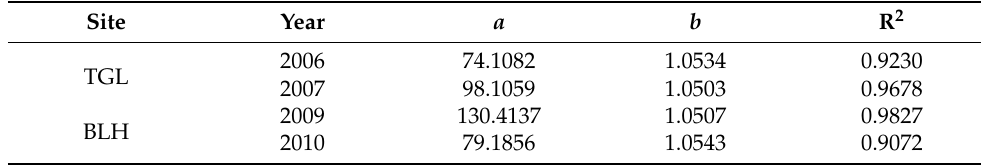
Table 5. The regression coefficients of Equation